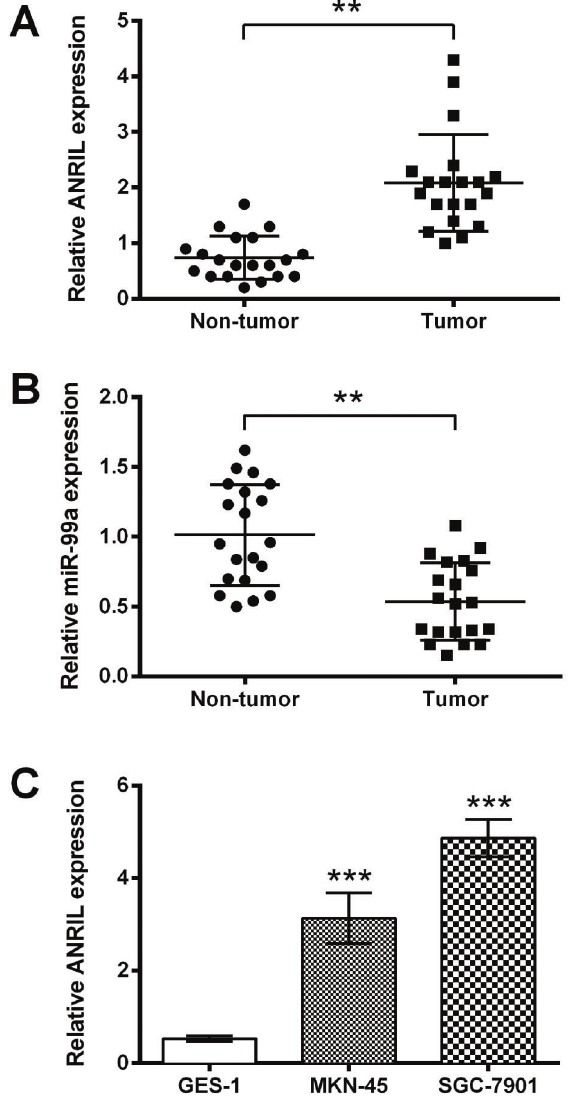
Figure 1. Antisense non-coding RNA in the INK4 locus (ANRIL) was up-regulated in gastric cancer. The levels of ANRIL and miR-99a were measured by qPCR. A , Expression of ANRIL and B , of miR-99a in gastric tumor tissues and adjacent non-tumor tissues (n=20). C , Expression of ANRIL in human gastric epithelial cell line GES-1 and human gastric cancer cell lines MKN-45 and SGC-7901. GAPDH acted as an internal control. Data are reported as means ± SD. **P o 0.01 (one-way ANOVA); ***P o 0.001 (two-tailed Student ’ s t